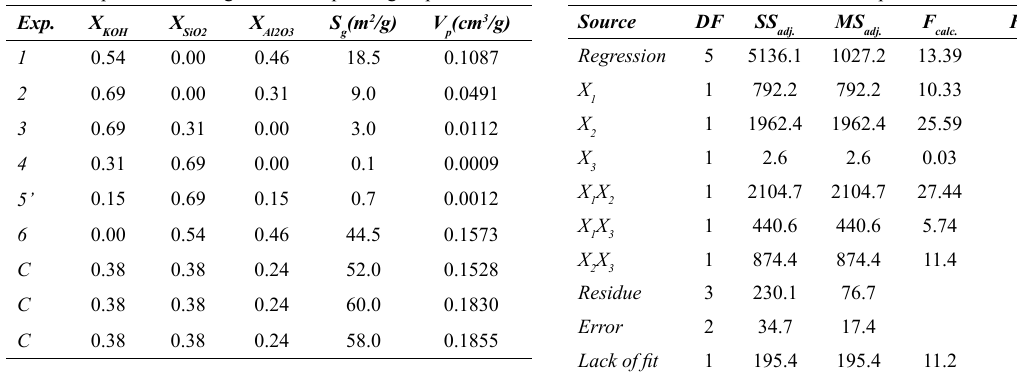
Table 3. Experimental design and corresponding responses. Table 4. ANOVA calculations for the specific surface area data.